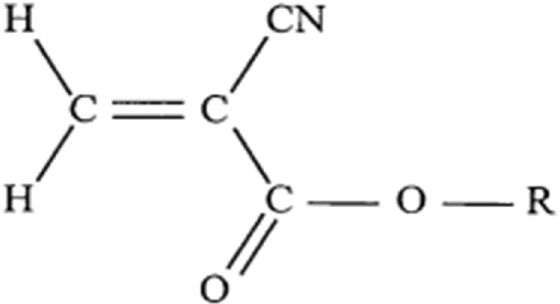
Figure 2. Chemical structure of monomeric cyanoacrylate. The R represents an alkyl